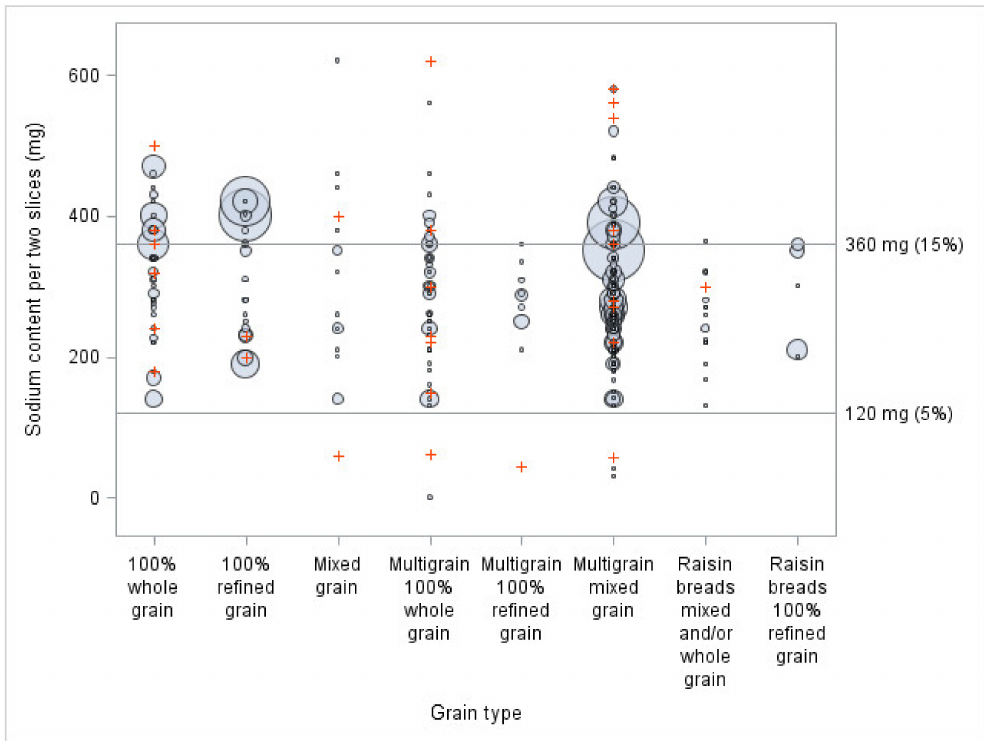
Figure 1. Sodium content per two slices of different breads, by type of grain and sales volume ( n = 294), compared to Health Canada’s percent daily values (DV). The bigger the circles, the higher the sales. Signs + represent sliced bread for which sales data were not available. A portion of 50 g was used when the weight of two slices was inferior to 50 g.